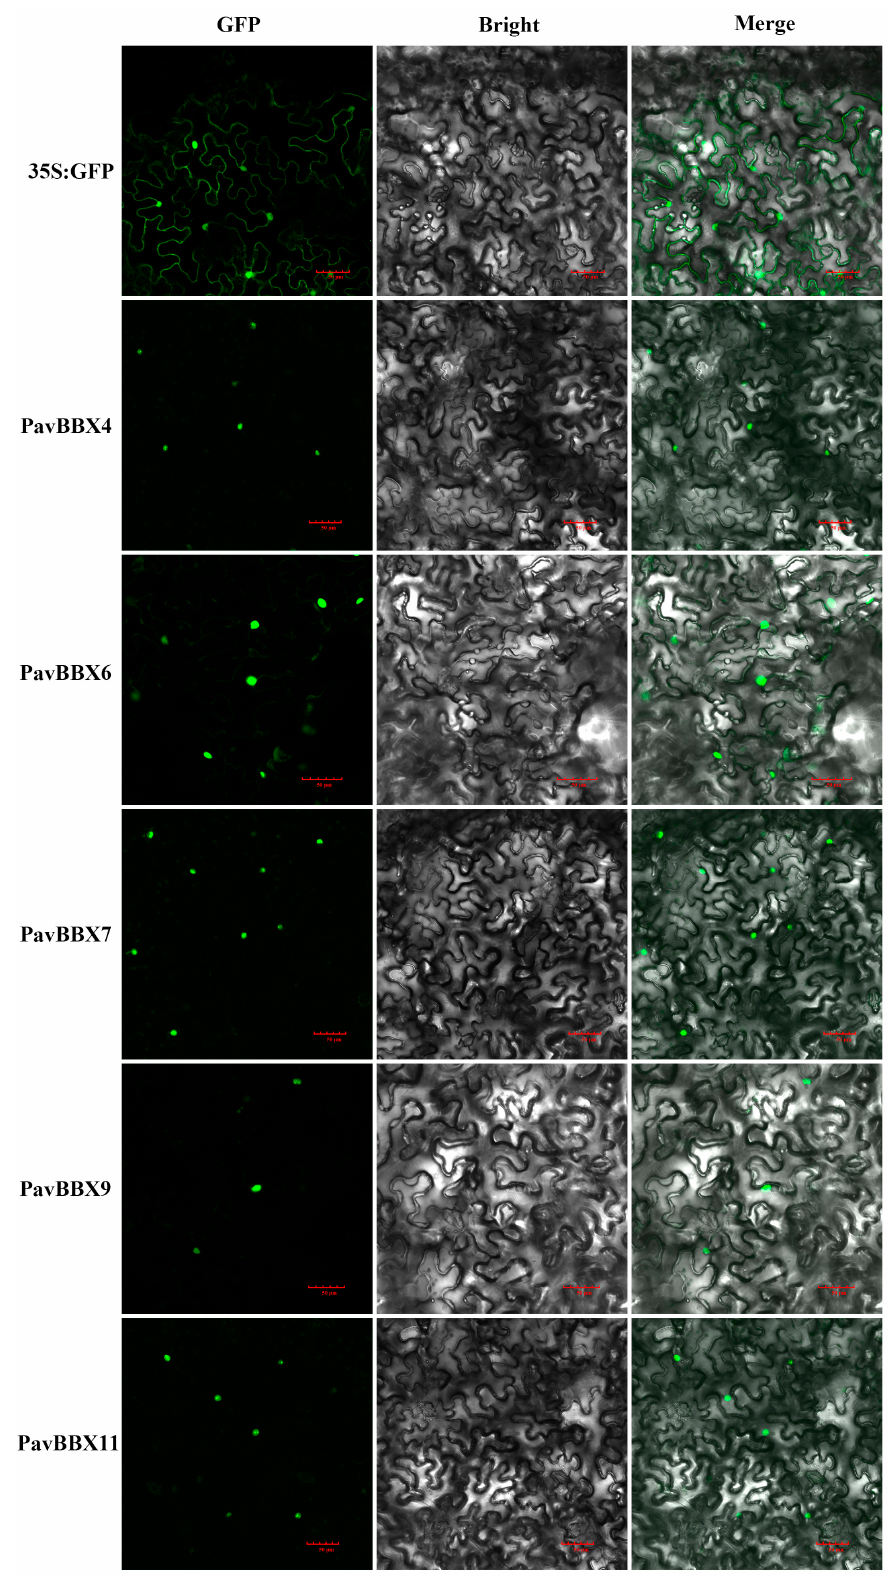
Figure 9. Subcellular localization of five GFP-fused PavBBX proteins. The five PavBBX-GFP fusion proteins (PavBBX4-GFP, PavBBX6-GFP, PavBBX7-GFP, PavBBX9-GFP, and PavBBX11-GFP) were transiently expressed in N. benthamiana leaves and observed by fluorescence microscopy 48 h later. Bar = 50 μ m.